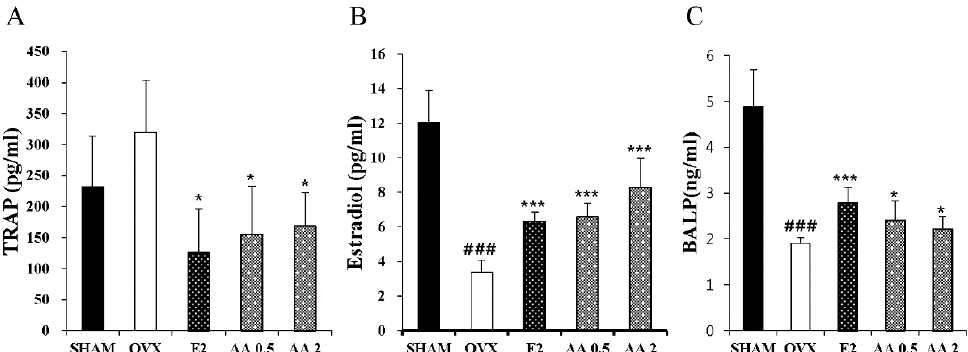
Figure 3. Effect of AA on serum TRAP, Estradiol, and BALP. In control, SHAM -operated mice and OVX mice with or without the injection of AA (0.5 μ g/g, 2 μ g/g/day, I.P) for six weeks, Serum ( A ) TRAP and ( B ) Estradiol were measured by ELISA kit. Each value represents the mean ± SD for n = 4~5. ### p < 0.001, significantly different from sham mice. * p < 0.05 and *** p < 0.001 significantly different from OVX mice.